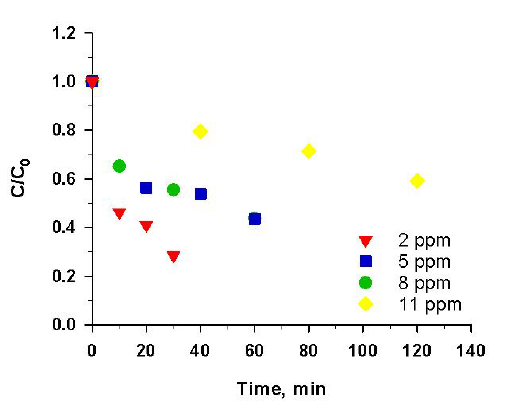
Fig. 8 Influence of different values of initial MB concentration in effluent on MB removal efficiency, Reaction conditions: V= 50 ml, pH=5, 50 mg Fe-ZIF-8 nanocatalyst.